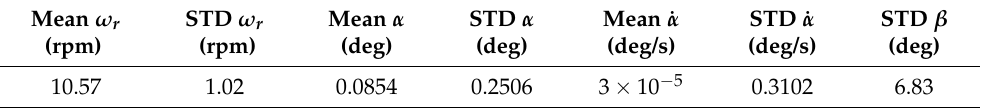
Figure 9. Simulation results of the proposed model-based twisting controller. Table 4. Mean error and standard deviation